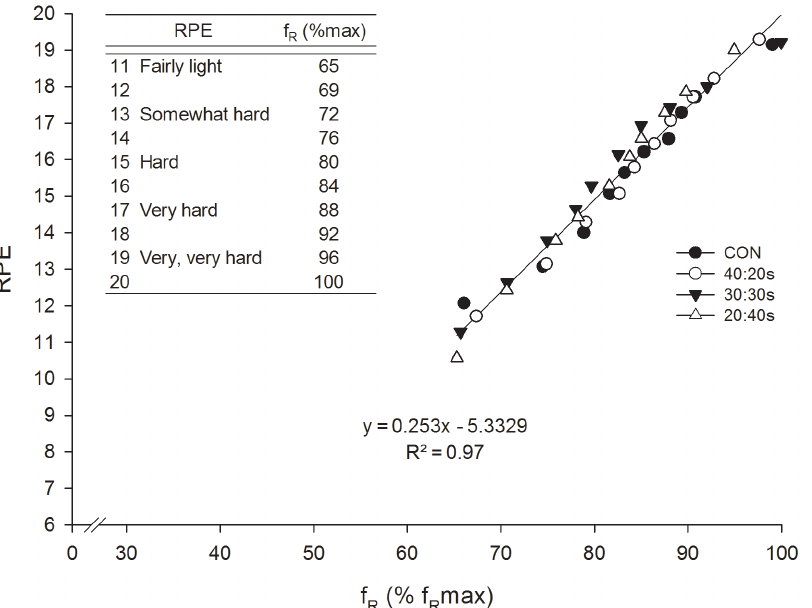
Figure 4. Relationship between perceived exertion and respiratory frequency. Relationship between RPE values and 3-min average values of f R , expressed as a % of the f R maximum value reached in the ramp incremental exercise test, for CON (closed circles), 40:20s (open circles), 30:30s (closed triangles) and 20:40s (open triangles). The linear regression results from pooling together data from the 4 experimental protocols. The regression equation of the relationship has been used to associate f R with the 15-point RPE scale for the RPE range registered in this study (from 11 to 20), as shown in the upper left corner of the chart.